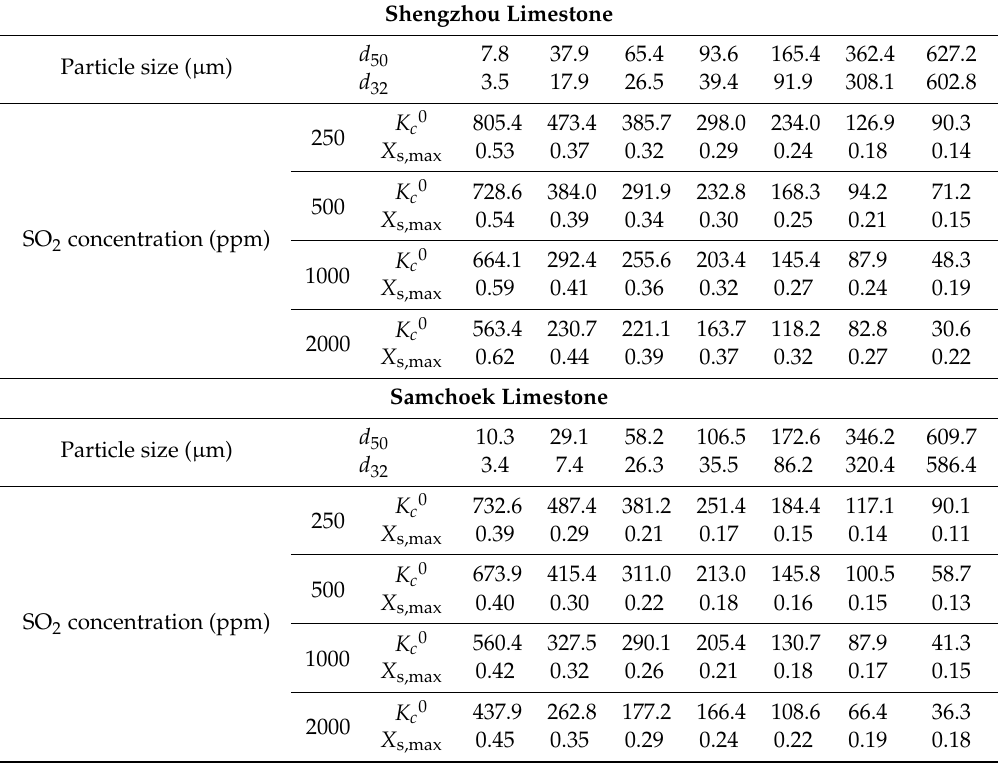
Table 4. Maximum sulfation conversion after infinite reaction time ( X s,max ) and the apparent reaction rate constant at the initial reaction ( K c 0 ) of the two kinds of limestones at di ff erent SO 2